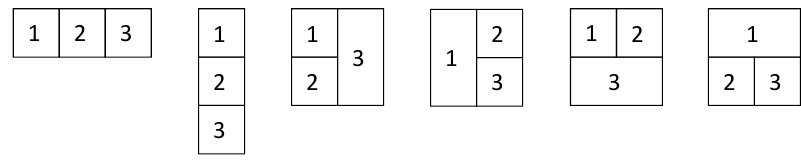
Figure 2 . Legal seed diagrams in X (123) Y (123): ladders and tennis